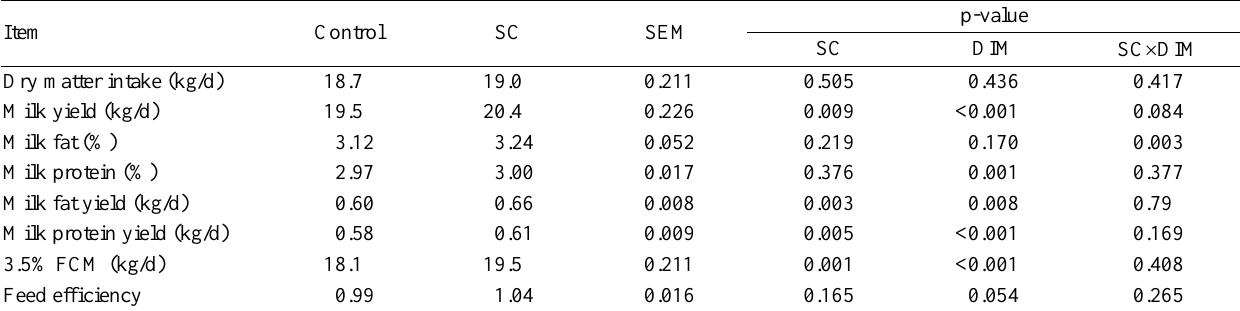
Table 3. Effect of yeast culture supplementation (SC) 1 on milk yield and milk composition on Farm 1